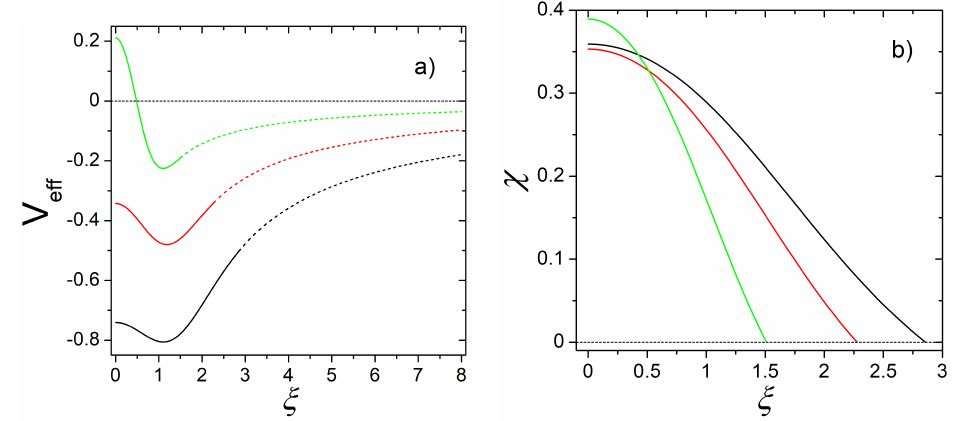
Figure 1. ( a ) The effective potential V eff ( ξ ) for u black (cid:39) 0.149, u red (cid:39) − 0.502, u green (cid:39) − 2.046. Dashed parts of the curves correspond to a pure gravitational potential − A · N / ξ outside the particle system; ( b ) the field χ ( ξ ) for the same values of chemical potential u , and χ ( ξ ) = 0 at ξ = ξ B . Here, A = 10, B = 20, Q = 1.36 for definiteness.